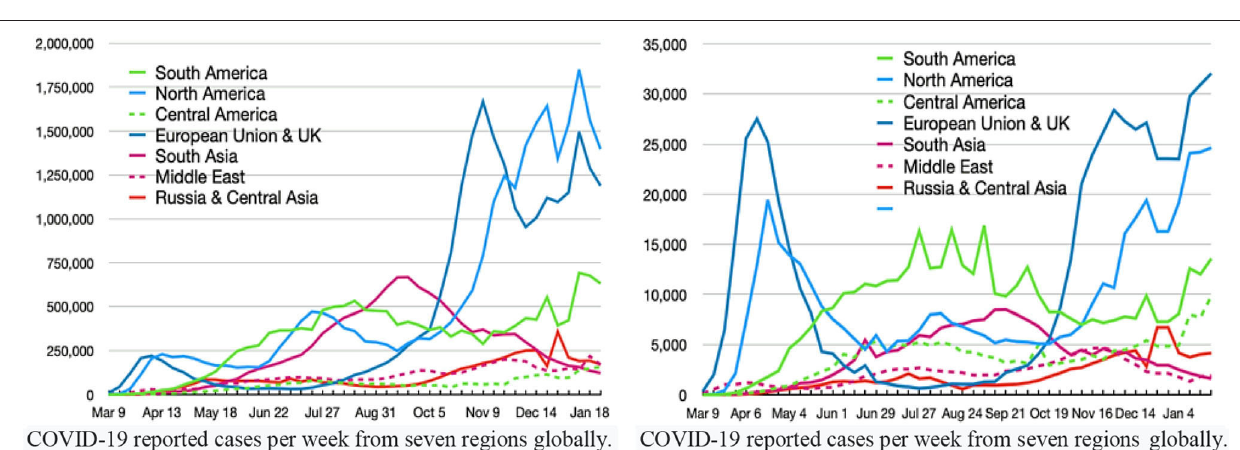
FIGURE 5 | COVID-19 identified cases vs. deaths due to coronavirus in the top seven regions, globally. Source: JHU and WHO